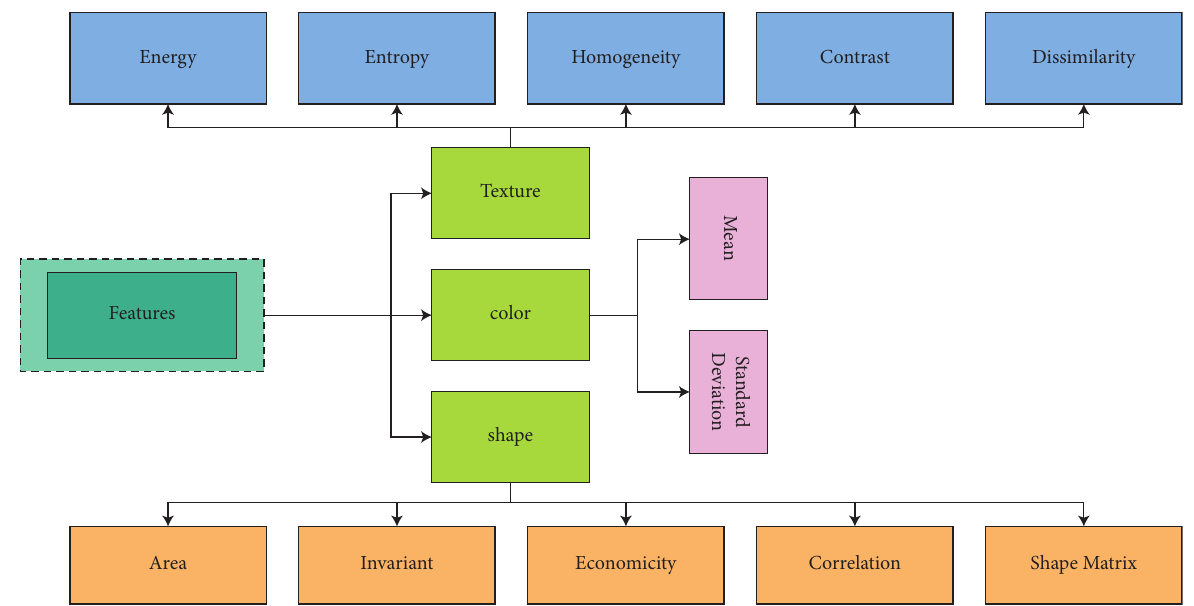
Figure 8: Features extraction of texture, color, and shape